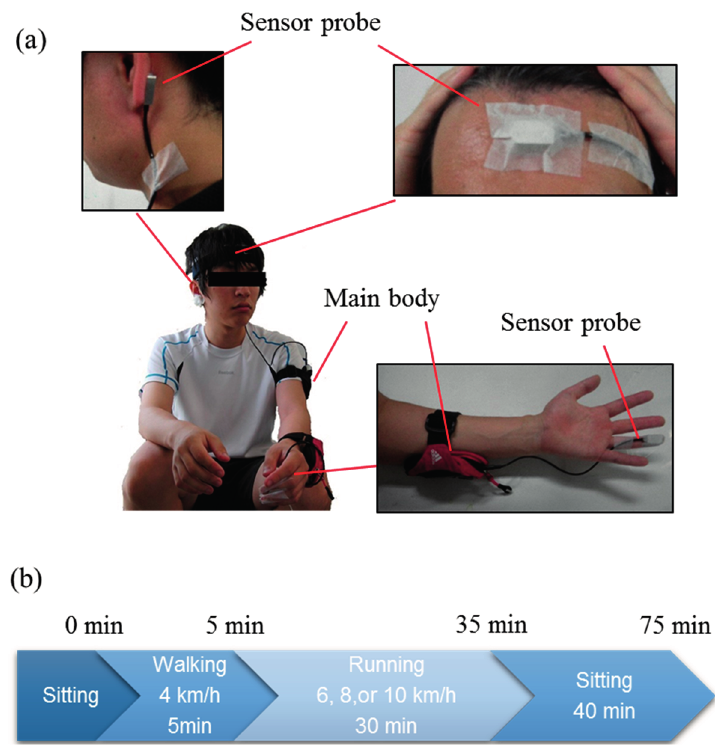
Figure 3. Actual pictures of running load experiment. Photographs of the attached MEMS blood flow sensors ( a ); and the experimental protocol ( b ). The MEMS blood flow sensor probes were attached using double-sided tape and surgical tape on the subject’s earlobe and the fourth fingertip or using a headband on the forehead. The main bodies of the